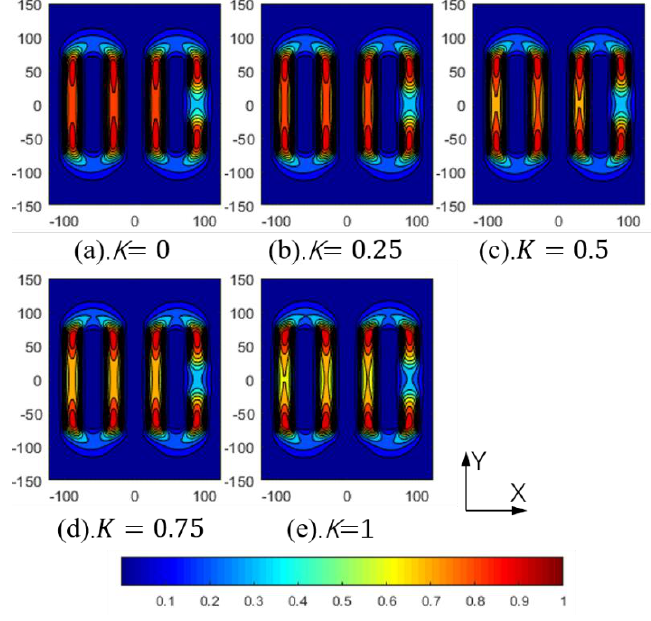
Figure 9. Normalized Joule heat generation.